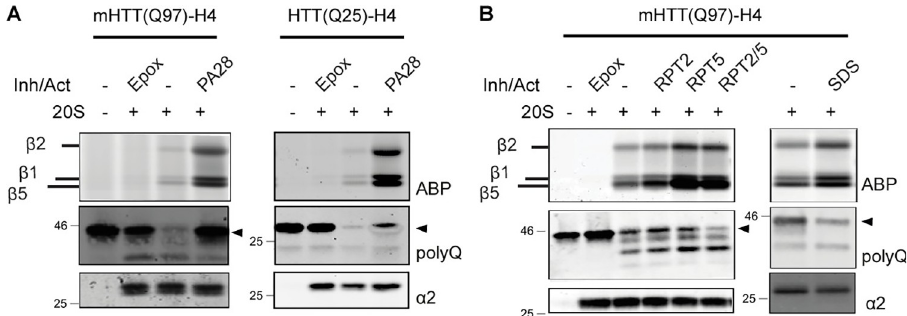
Fig 3. PA28 αβ hampers in vitro degradation of mHTT by the proteasome. (A) mHTT(Q97)exon1-H4 or mHTT (Q25)exon1-H4 incubated with purified 20S proteasomes in the absence or presence of PA28 αβ . Activating purified 20S proteasomes with PA28 αβ prevents degradation of mHTT(Q97)exon1-H4 and reduces degradation of mHTT (Q25)exon1-H4 (arrowheads). (B) Incubation of 20S proteasomes with RPT2, RPT5, RPT2 and 5 or SDS increases proteasome accessibility and activity as shown by ABP labeling, and improves the degradation of mHTT(Q97) exon1-H4 (arrowhead). Inh = inhibitor; Act = activator; Epox = epoxomicin.